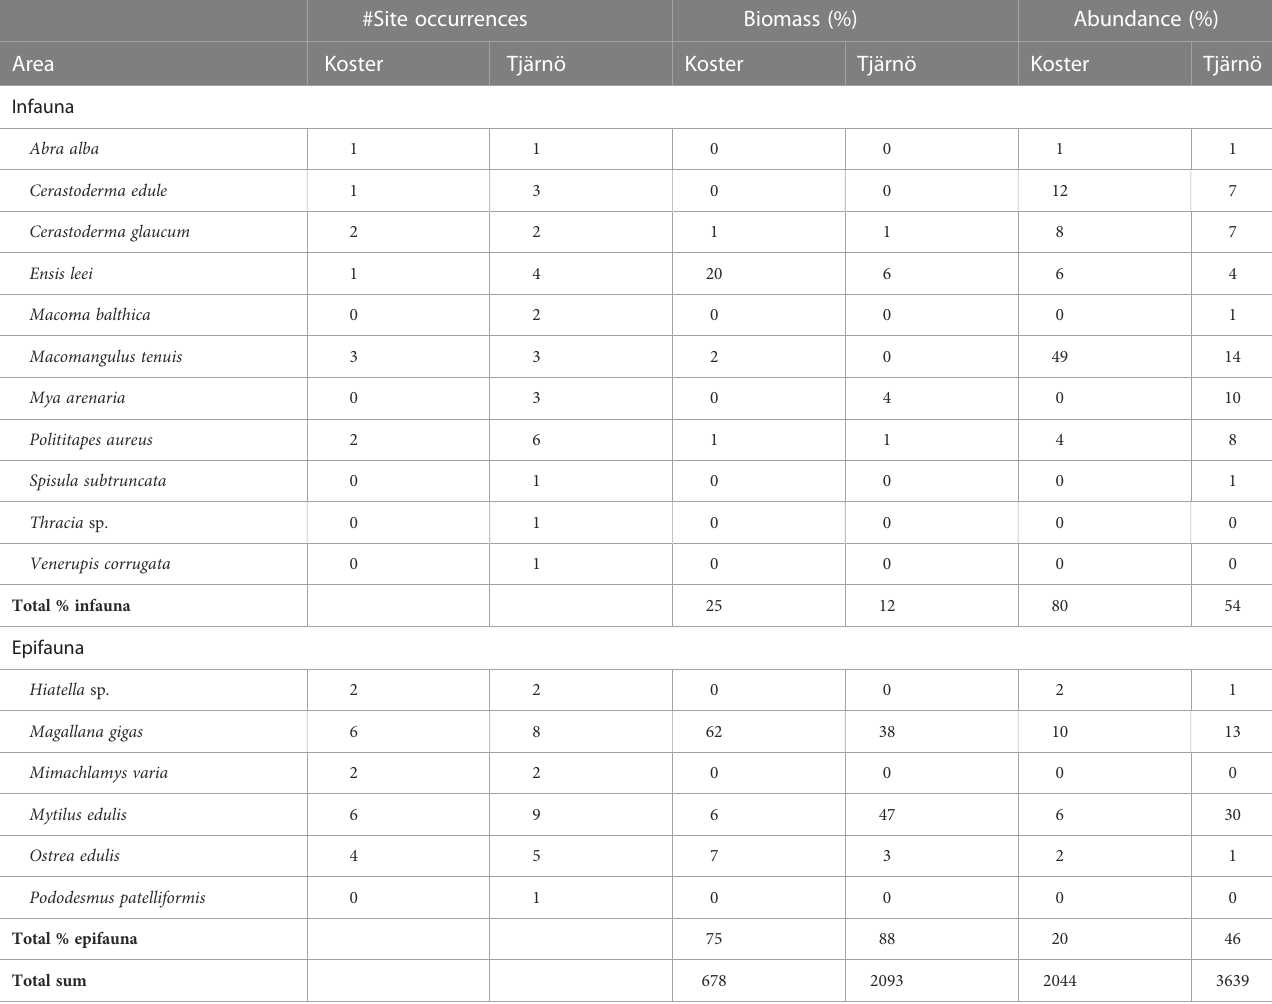
TABLE 2 Summary of infaunal and epifaunal bivalve species observations: #site occurrences (of a maximum 10), relative biomass and abundance in Tjärnö and